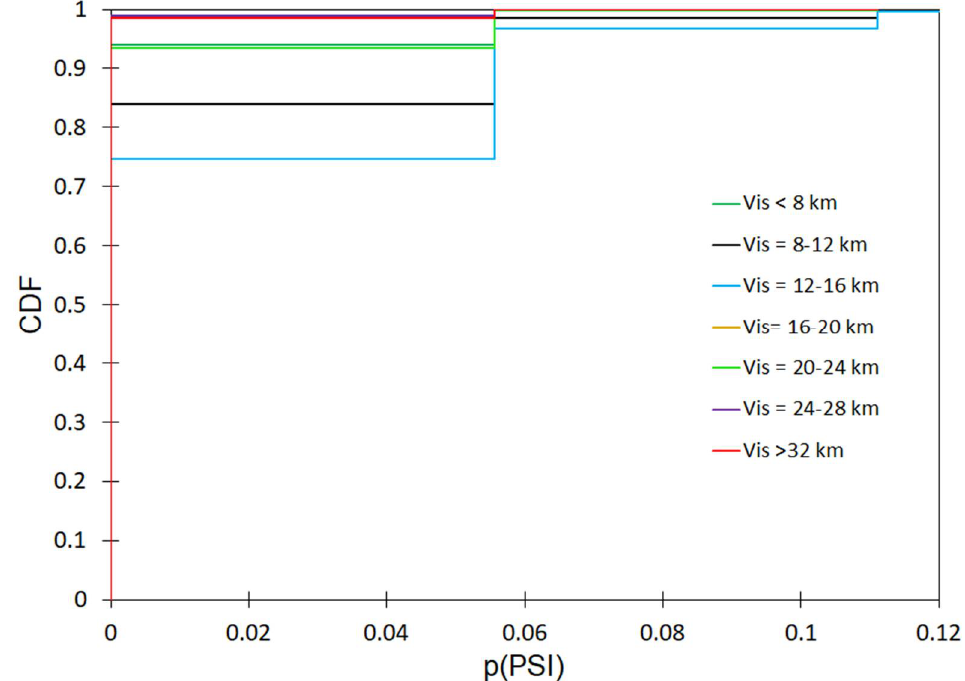
Figure A34. Effect of visibility on the incidence of high spring mortality for dry days.